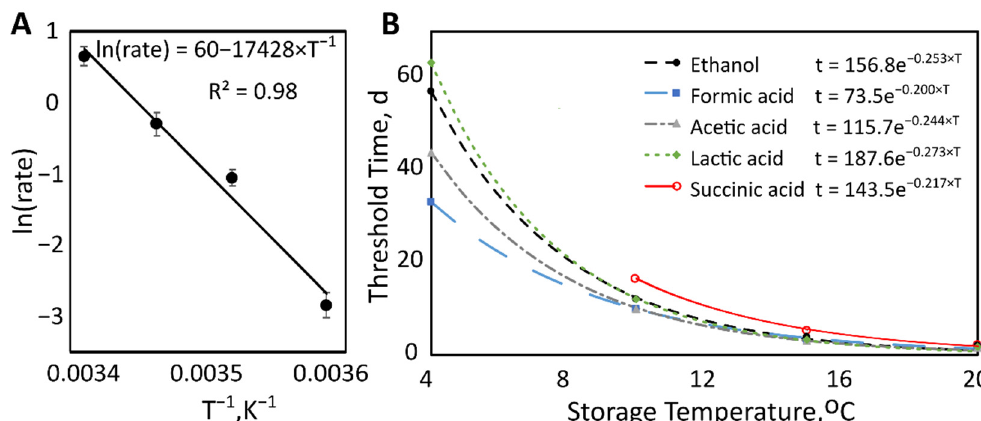
Figure 3. ( A ) Arrhenius plot showing the effect of temperature on the rate of citric acid degradation. Natural log of the rate with standard error bars by reciprocal absolute storage temperature (K − 1 ). ( B ) Threshold time (days) by storage temperature (°C). Threshold time decreased exponentially as storage temperature increased.